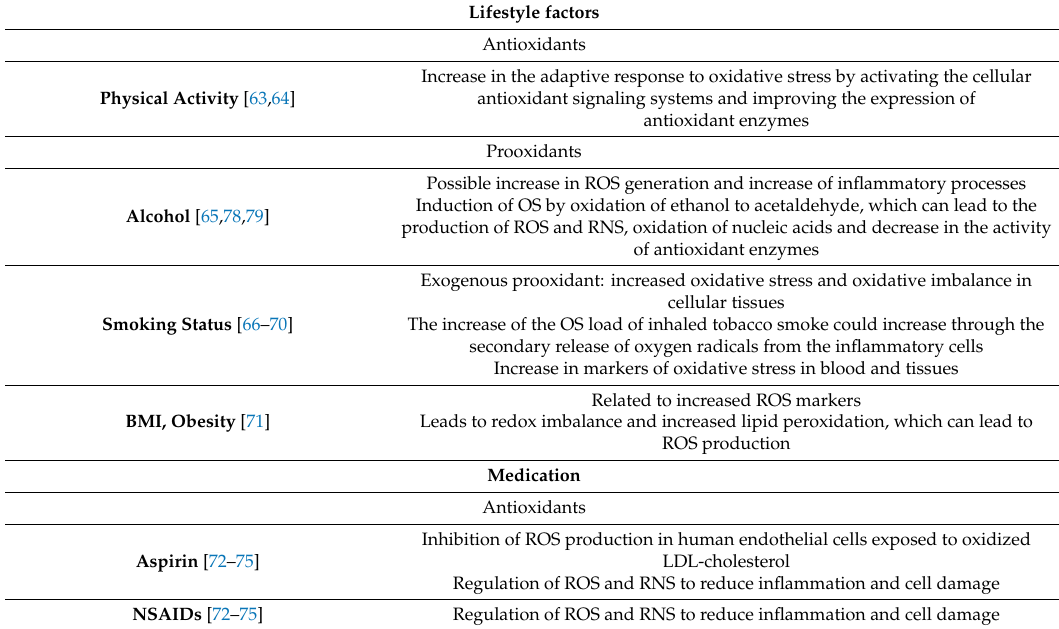
Table 7. Rationale for the inclusion of some components in a priori OBS in relation to